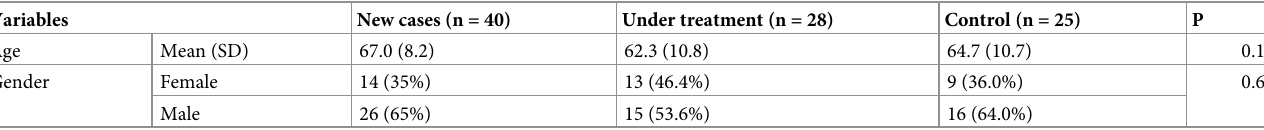
Table 1. Comparison of mean age and gender distribution among three study